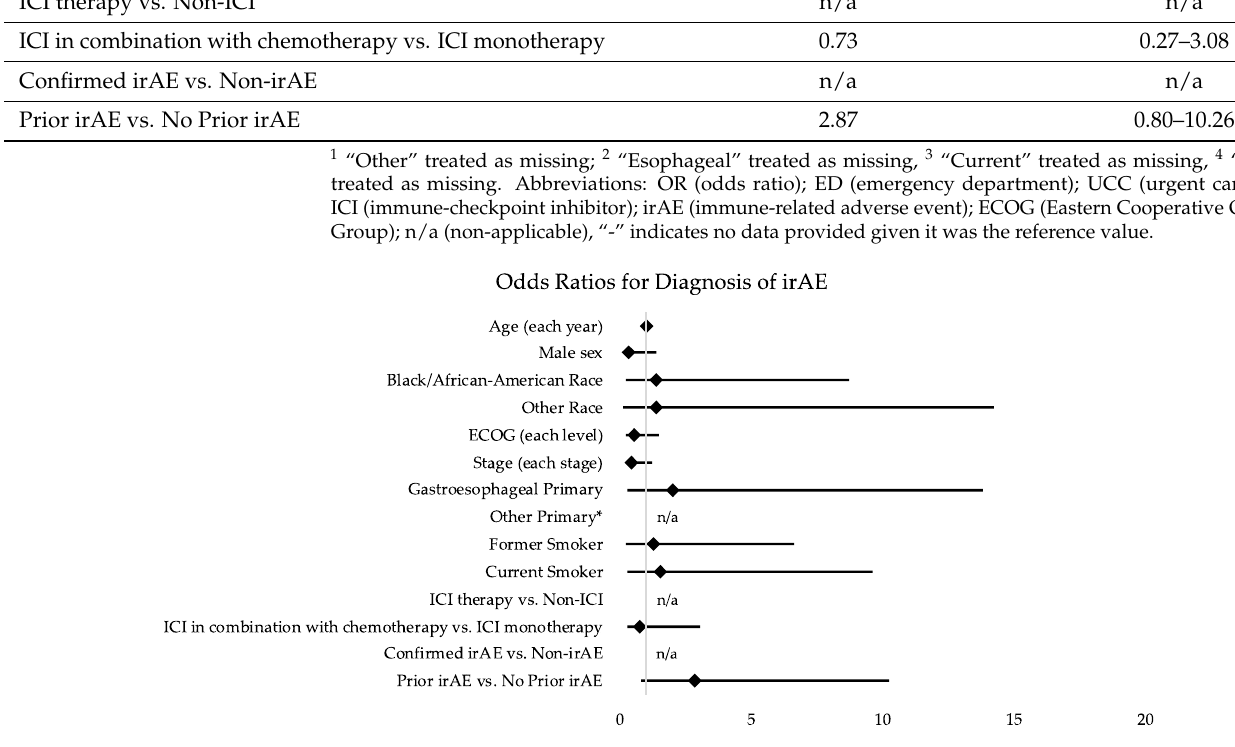
Figure 4. Odds ratios for clinical features and diagnosis of irAE. Abbreviations: OR (odds ratio); ED (emergency department); UCC (urgent care clinic); ICI (immune-checkpoint inhibitor); irAE (im- mune-related adverse event); ECOG (Eastern Cooperative Oncology Group). * Could not be calcu- lated because there were no observed irAEs for “Other